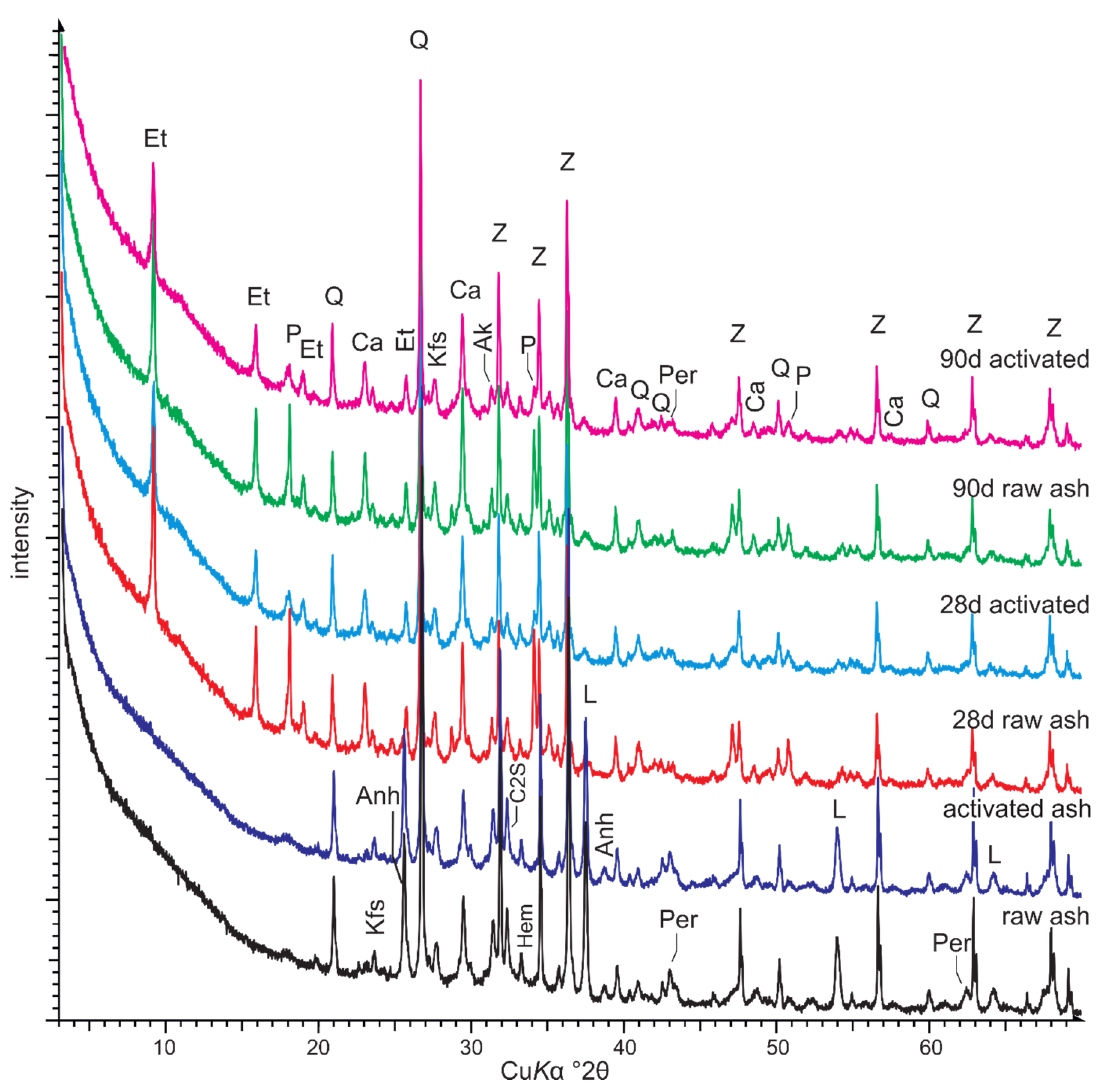
Figure 4. Representative XRD patterns of the raw and 4 min mechanically activated ash and activated ash pastes after 28 and 90 days of curing. Legend for major peaks: Ak—akermanite; Anh—anhydrite; Ca—calcite; C2S—belite; Et—ettringite; Hem—hematite; Kfs—K-feldspar; L—lime; P—portlandite; Per—periclase; Q—quartz; Z—zinc oxide. ZnO spike was added to estimate the amorphous phase content. Table 1. The chemical composition of raw and mechanically activated ash, wt%. L.O.I.—Loss on ignition at 950 °C. SiO